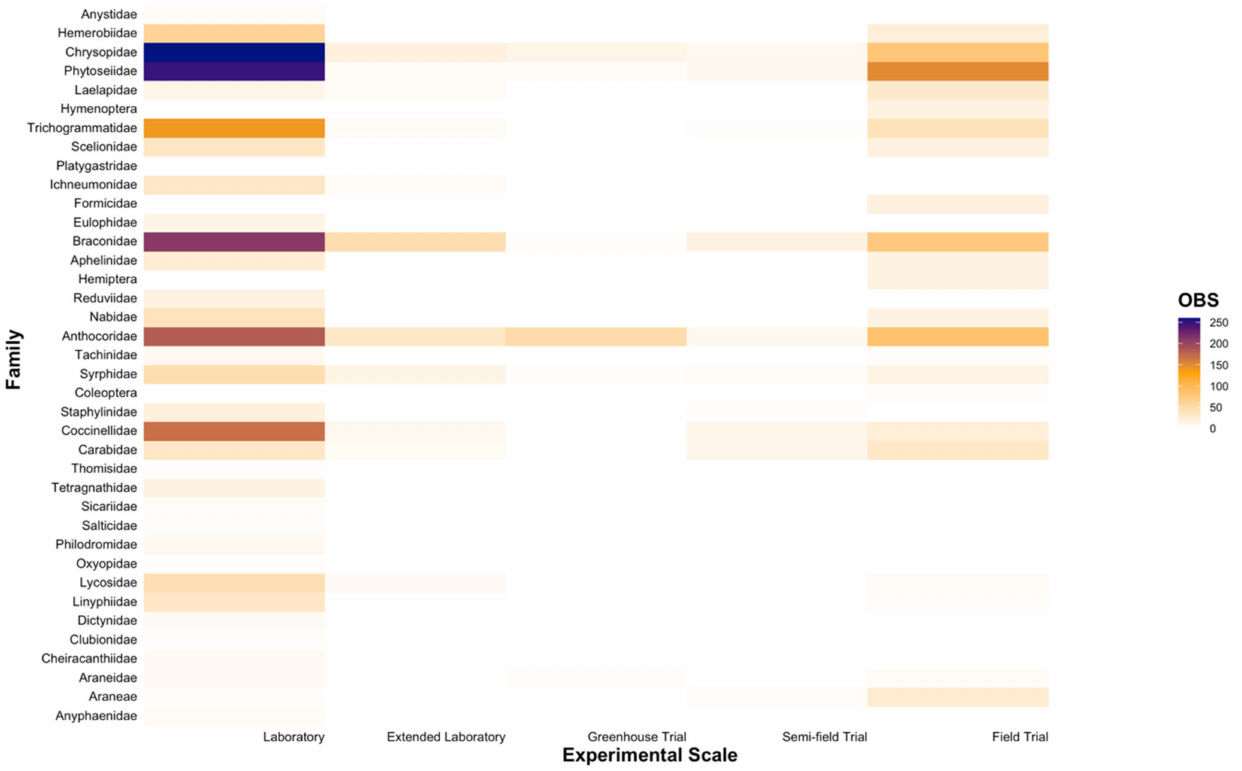
Figure 6. The number of entries (OBS) conducted for families of natural enemies across five experimental scales (Laboratory, Extended Laboratory, Greenhouse Trial, Semi-field Trial, Field Trial) across chemical Modes of Action relevant to the Australian grains industry.